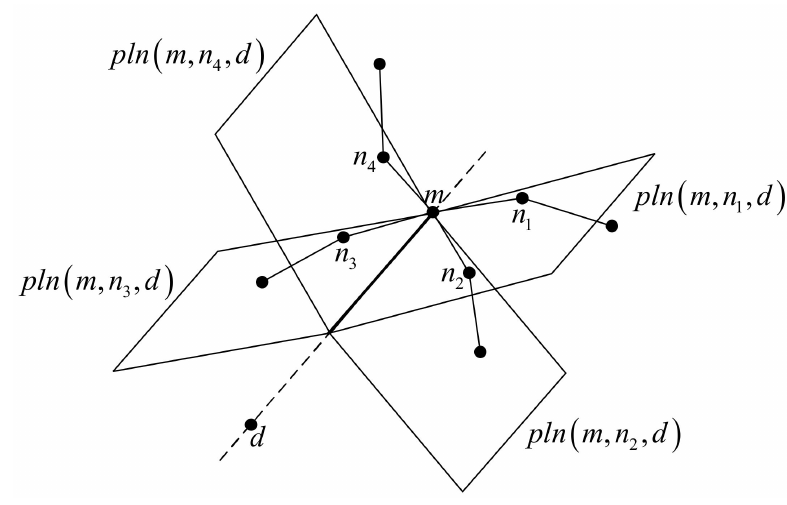
Figure 10. Construction of multi-projection plane.